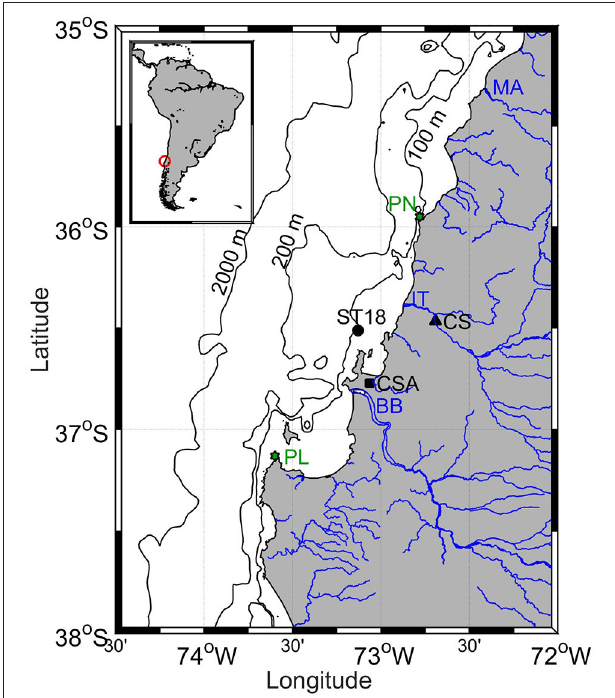
FIGURE 1 | Geographic location of Station 18 (ST18), Coelemu Station (CS), Carriel Sur Airport (CSA), Punta Nugurne (PN), Punta Lavapié (PL), Itata (IT), Biobío (BB), and Maule (MA) rivers. In addition 100, 200, and 2,000m isobaths are